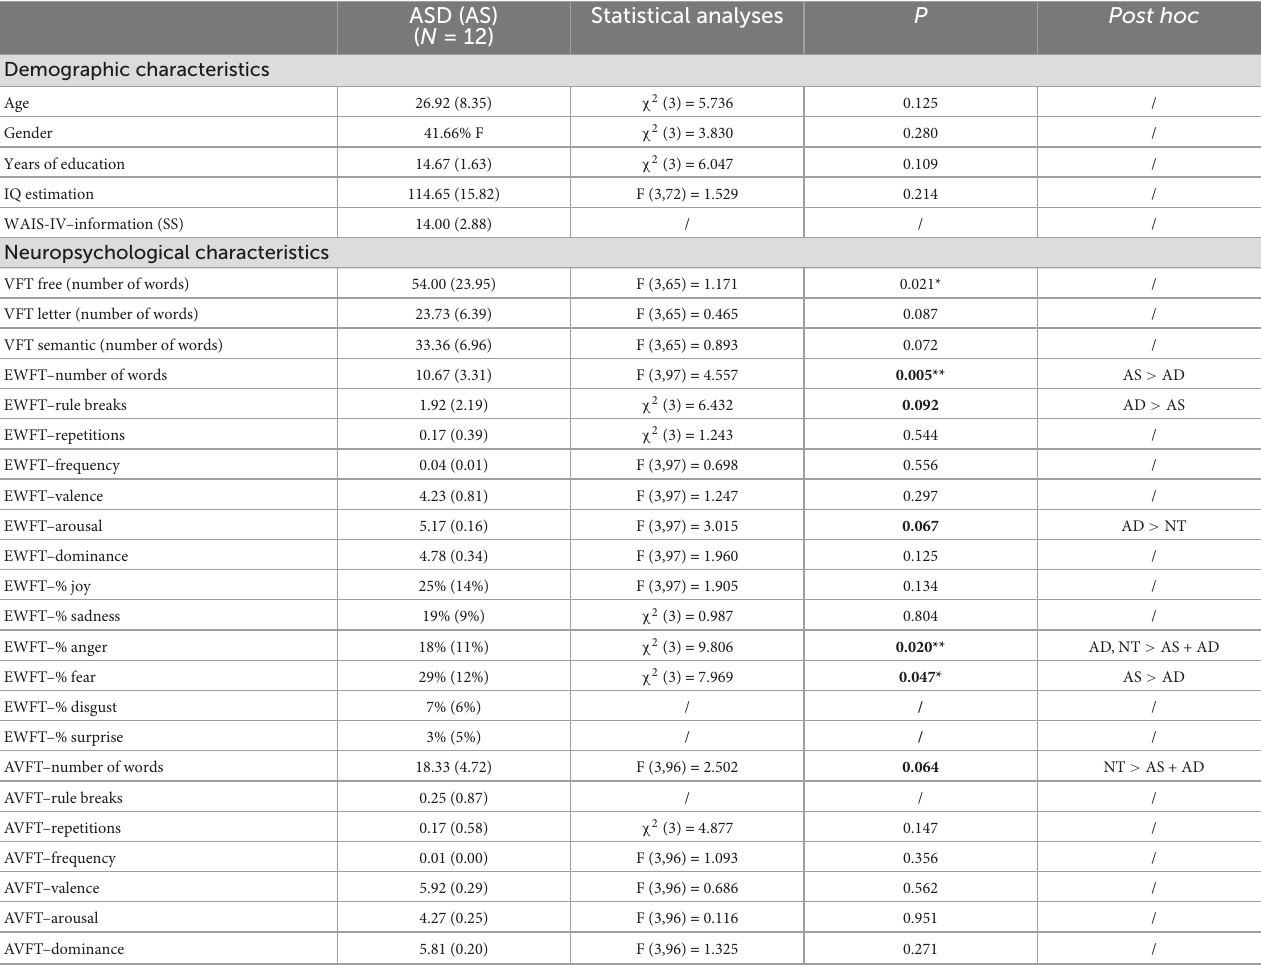
TABLE 4 Comparison of demographic and neuropsychological characteristics of autistic adults ( n = 12) with the three other groups.